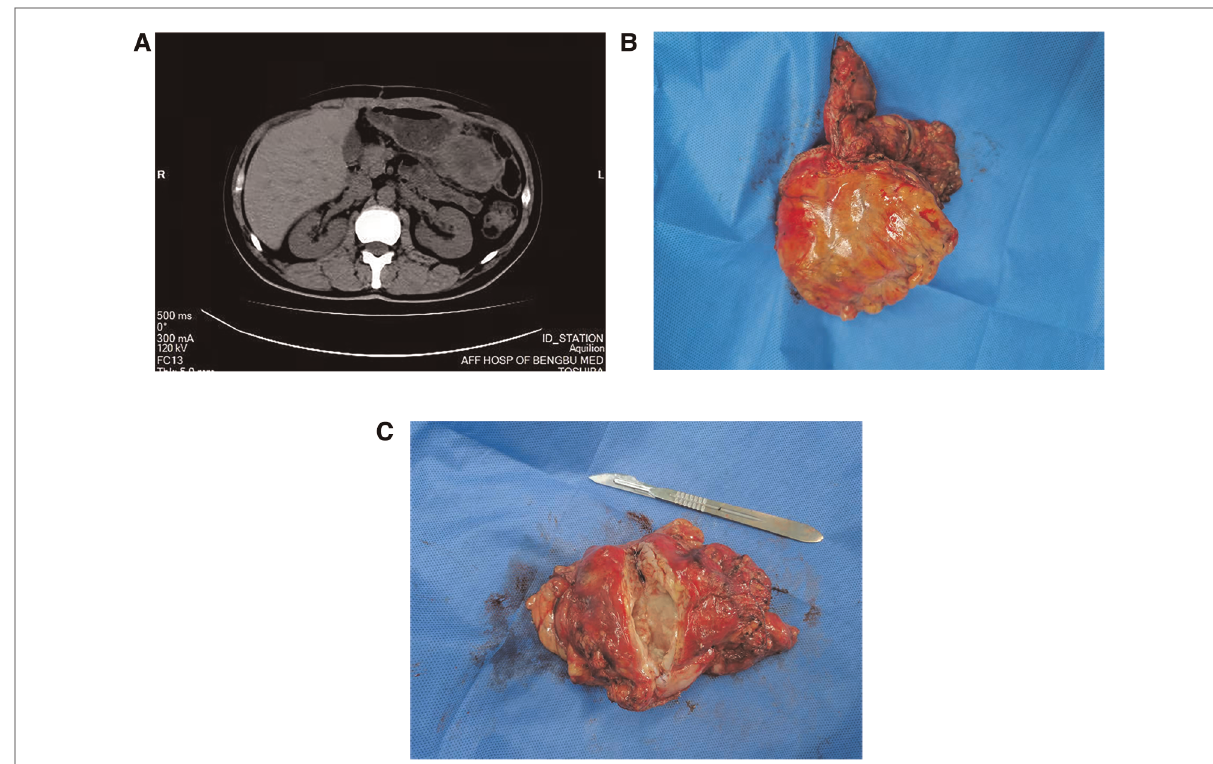
FIGURE 3 Related imaging data and clinical specimens of gastric recurrence of hepatic sarcomatoid carcinoma. A regular CT scan of the abdomen showed the presence of an irregularly shaped and uneven-density occupancy in the area between the greater curvature of the stomach and the omental sac ( A ), the size was approximately 53×78×100 mm; the specimen is off-white ( B ) and shows internal necrosis ( C